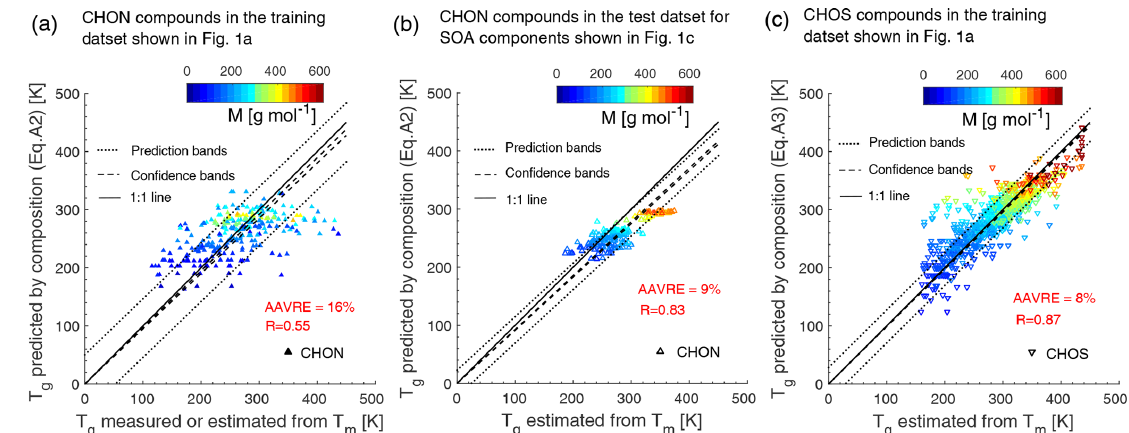
Figure A1. T g predicted by elemental composition (Eq. A2) compared to (a) measured or otherwise estimated T g by the Boyer–Kauzmann rule using measured T m for CHON compounds in the training dataset and (b) estimated T g by the Boyer–Kauzmann rule with T m estimated by the EPI Suite for CHON compounds in the test dataset for SOA components. (c) T g predicted by elemental composition (Eq. A3) compared to estimated T g by the Boyer–Kauzmann rule with T m estimated by the EPI Suite for CHOS compounds in the training dataset. The dashed and dotted lines show 68% confidence and prediction bands, respectively. The correlation coefficient ( R ) and the average absolute value of the relative error (AAVRE) are included in each figure legend.